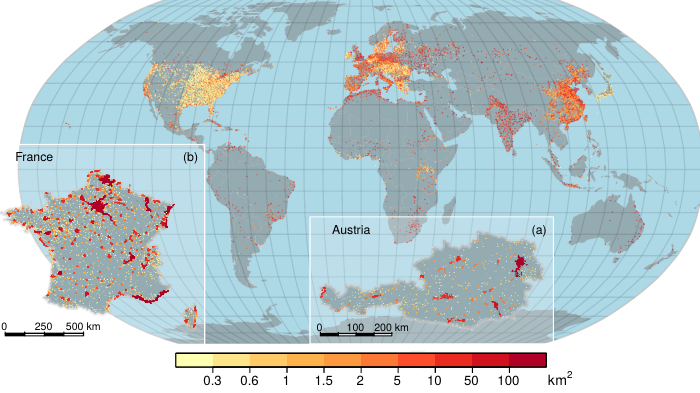
Figure 2. Global map of cluster area in km 2 for l = 4 km. For better visibility all clusters (15,640) are plotted as single dots, instead of spatial extent. Notice that only clusters with associated population information are displayed. Exemplary the spatial extent is shown for ( a ) Austria (460 clusters) and ( b ) France (1907 clusters). Due to the fact that small clusters are much more often than big ones, they are more present in the global dotted map compared to the spatial explicit country examples. Furthermore noticeable is the highly sprawled small urban clusters in the US compared with the concentrated dens urban hot spots in